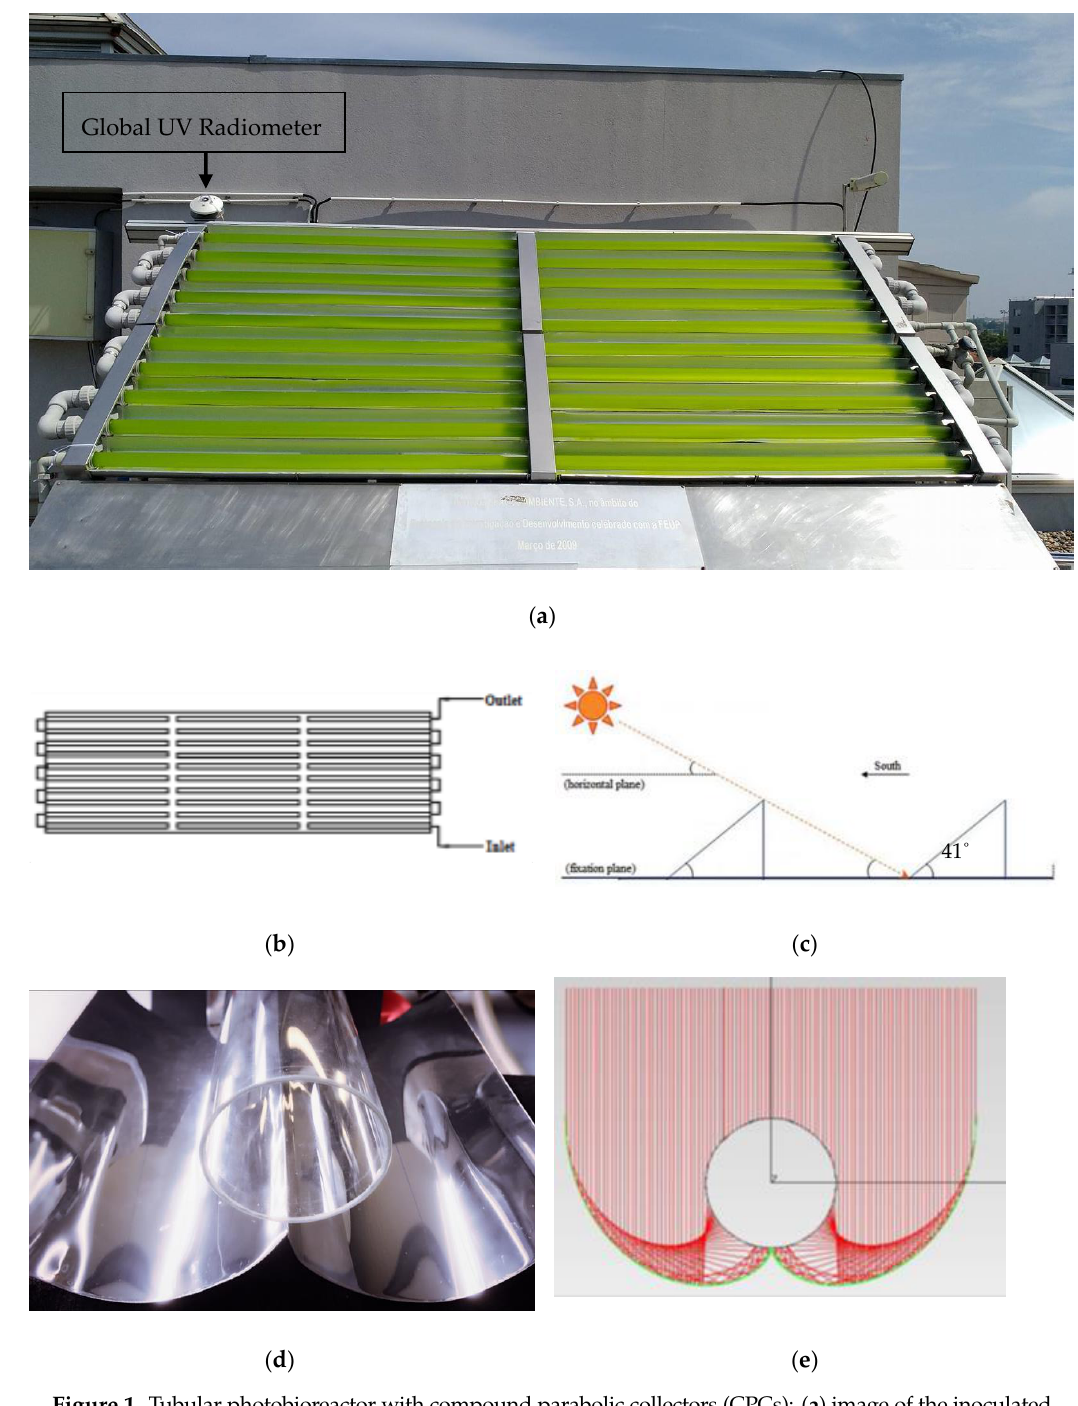
Figure 1. Tubular photobioreactor with compound parabolic collectors (CPCs): ( a ) image of the inoculated culture; ( b ) scheme of the fluid flow configuration (in series, serpentine flow); ( c ) orientation in relation to the sun; ( d ) front view of CPCs; ( e ) ray-trace analysis with CPCs, considering an incident angle of 90˚.